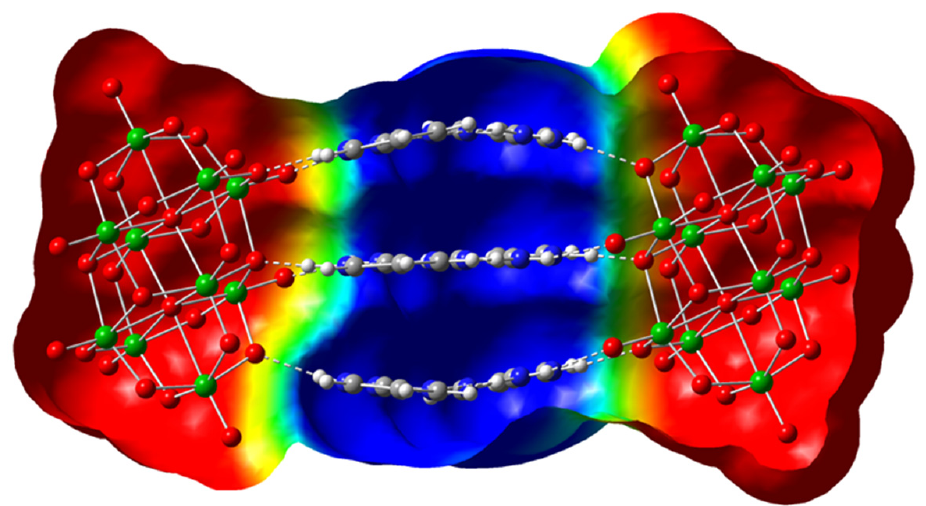
Figure 8. Molecular electrostatic potential map of Compound 1 , calculated at the theory level